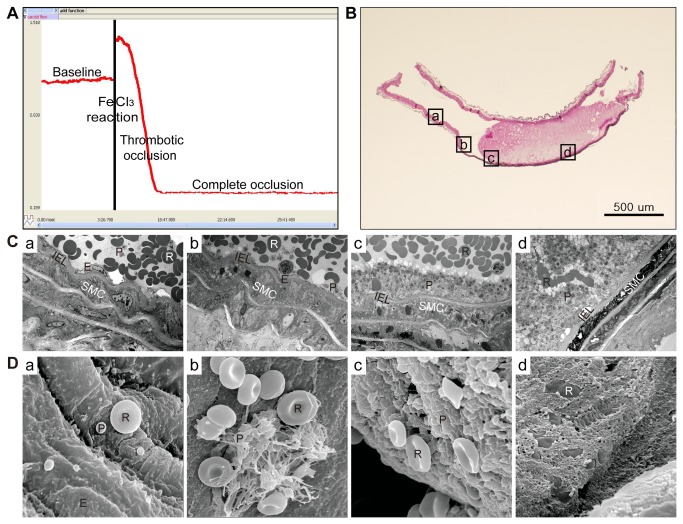
Reliability of the FeCl3-induced arterial thrombosis model.
A: Blood flow was monitored using an ultrasonic Doppler ﬂow meter in the carotid artery. Representative time-flow curve from FeCl3-induced arterial thrombosis. Complete occlusion was defined as absence of blood flow for 10 minutes. B: Hematoxylin and eosin staining of the carotid artery with thrombotic occlusion after FeCl3 treatment. Original magnification ×100. C: Transmission electron microscopy. D: Scanning electron microscopy. Boxes in Figure 2B indicate sites of electron microscopy images. a) Region farthest from the site of FeCl3 application with intact vascular structure and normally shaped erythrocytes and discoid platelets. b) Mildly damaged region. Empty endothelial cells with loss of organelles, activated and aggregated platelets, and platelets adhering to the luminal surface. c) Thrombus border region with no intact endothelial cells. Activated and aggregated platelets firmly adhered to the damaged region of the luminal surface. d) Severely damaged region with artery completely occluded by a platelet-rich thrombus containing several erythrocytes. FeCl3-induced damage caused loss of vascular undulation, but the internal elastic lamina was intact even in the severely damaged region. R: erythrocyte, P: platelet, E: endothelial cell, SMC: smooth muscle cell, IEL: internal elastic lamina. Original magnification ×2,000 (TEM), ×5,000 (SEM).